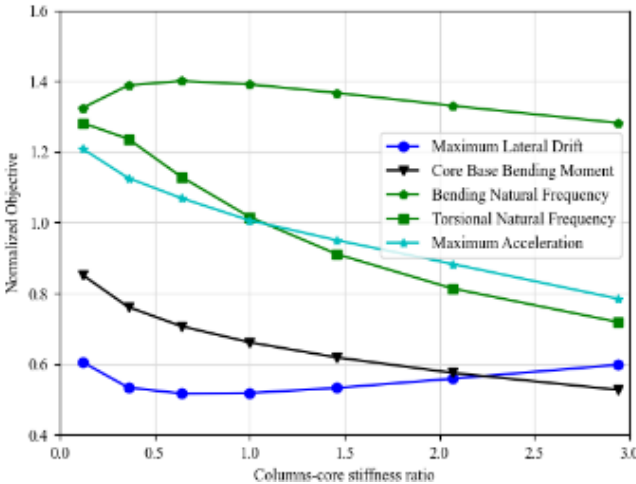
Figure 8. Influence of the column-core stiffness ratio on the objectives/criteria